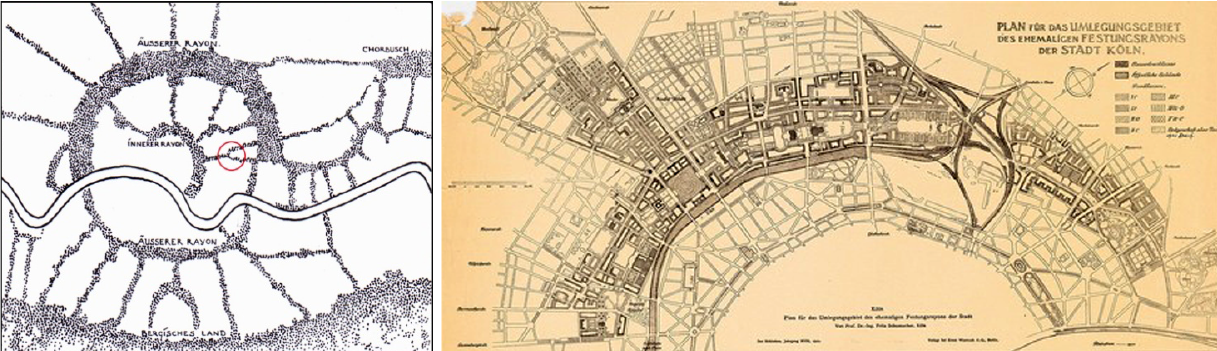
Figure 9. From left to right: F. Schumacher, The Green Belt of Cologne: Concept , Cologne, 1919. Source: (Curdes, 2000); F. Schumacher, Competition for the development of the inner district, Cologne, 1920. Site plan 1:10000 (Schumacher,